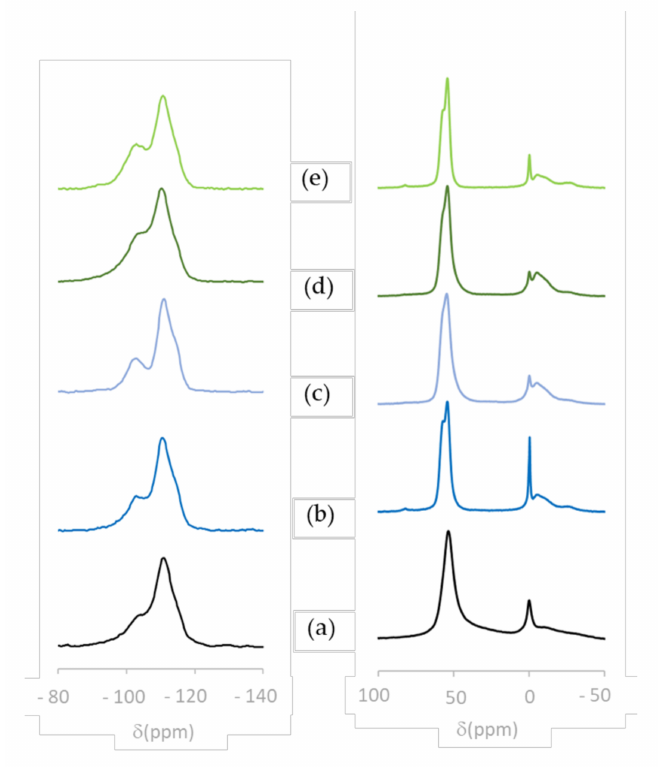
Figure 1. 29 Si MAS-NMR ( left ) and 27 Al MAS-NMR ( right ) spectra of parent and modified samples. ( a ) BEA; ( b ) BEA0.2; ( c ) BEA0.2AT; ( d ) BEA0.4; ( e ) BEA0.4AT.